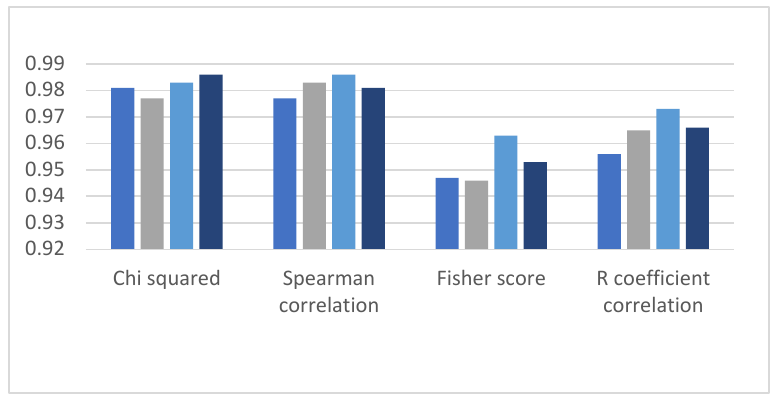
Figure 11. Precision using enhanced LR.